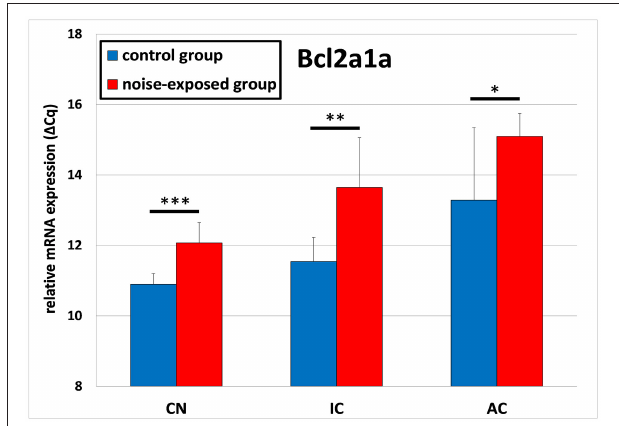
FIGURE 1 | Relative mRNA expression of Bcl2a1a . Presented are 1 Cq values (mean ± S.D.) in the cochlear nucleus (CN), inferior colliculus (IC) and auditory cortex (AC) of the mouse central auditory pathway immediately after noise trauma compared to unexposed controls. Asterisks indicate significant differences between control and trauma group (* p < 0.05; ** p < 0.01; *** p < 0.001).